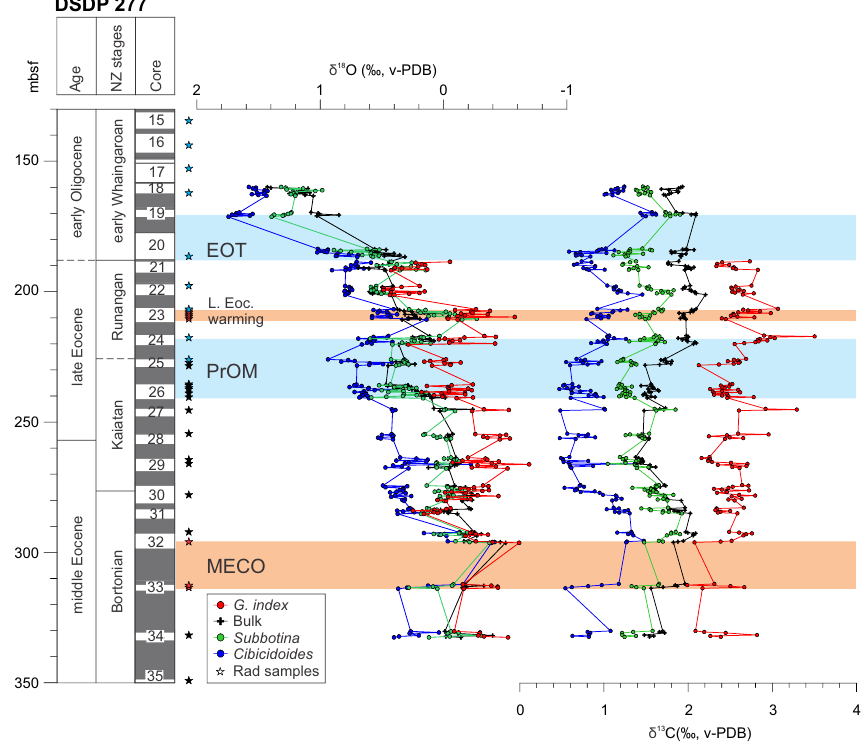
Figure 3. DSDP Site 277 δ 18 O and δ 13 C records and location of studied radiolarian samples within the MECO and late Eocene warming interval (red stars) and radiolarian-rich upper Eocene–lower Oligocene interval (blue stars).